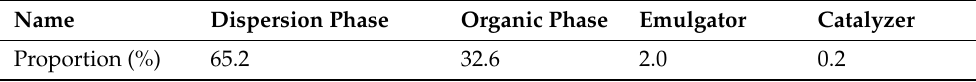
Table 2. The reaction components and their proportions for emulsion